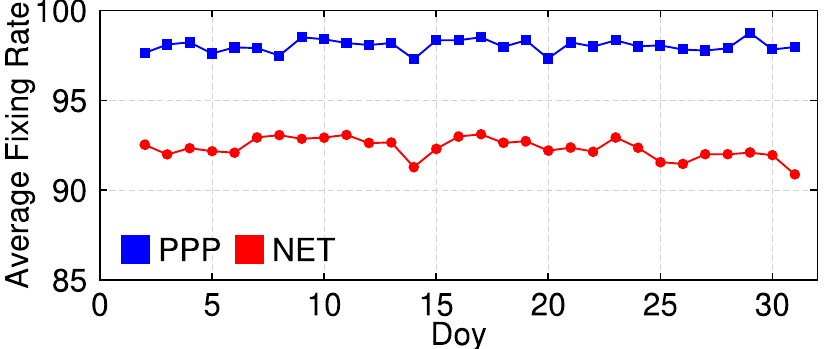
Figure 8. Means of ambiguity fixing rate of all stations.